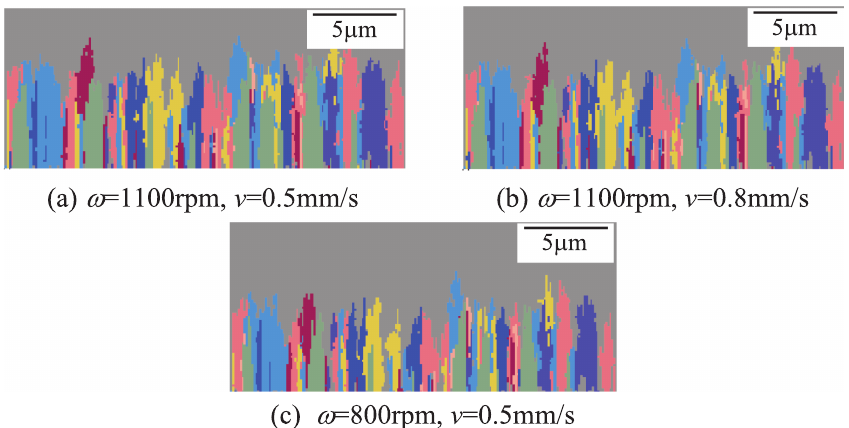
Figure 15: Formation of acicular α phase morphology in 600°C in different welding